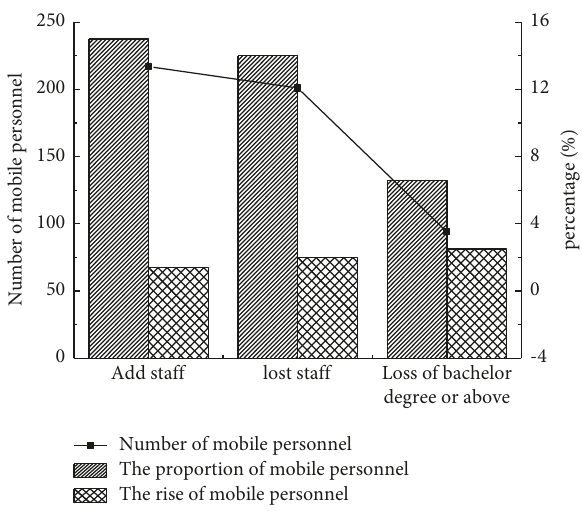
Figure 4: The flow of personnel in the